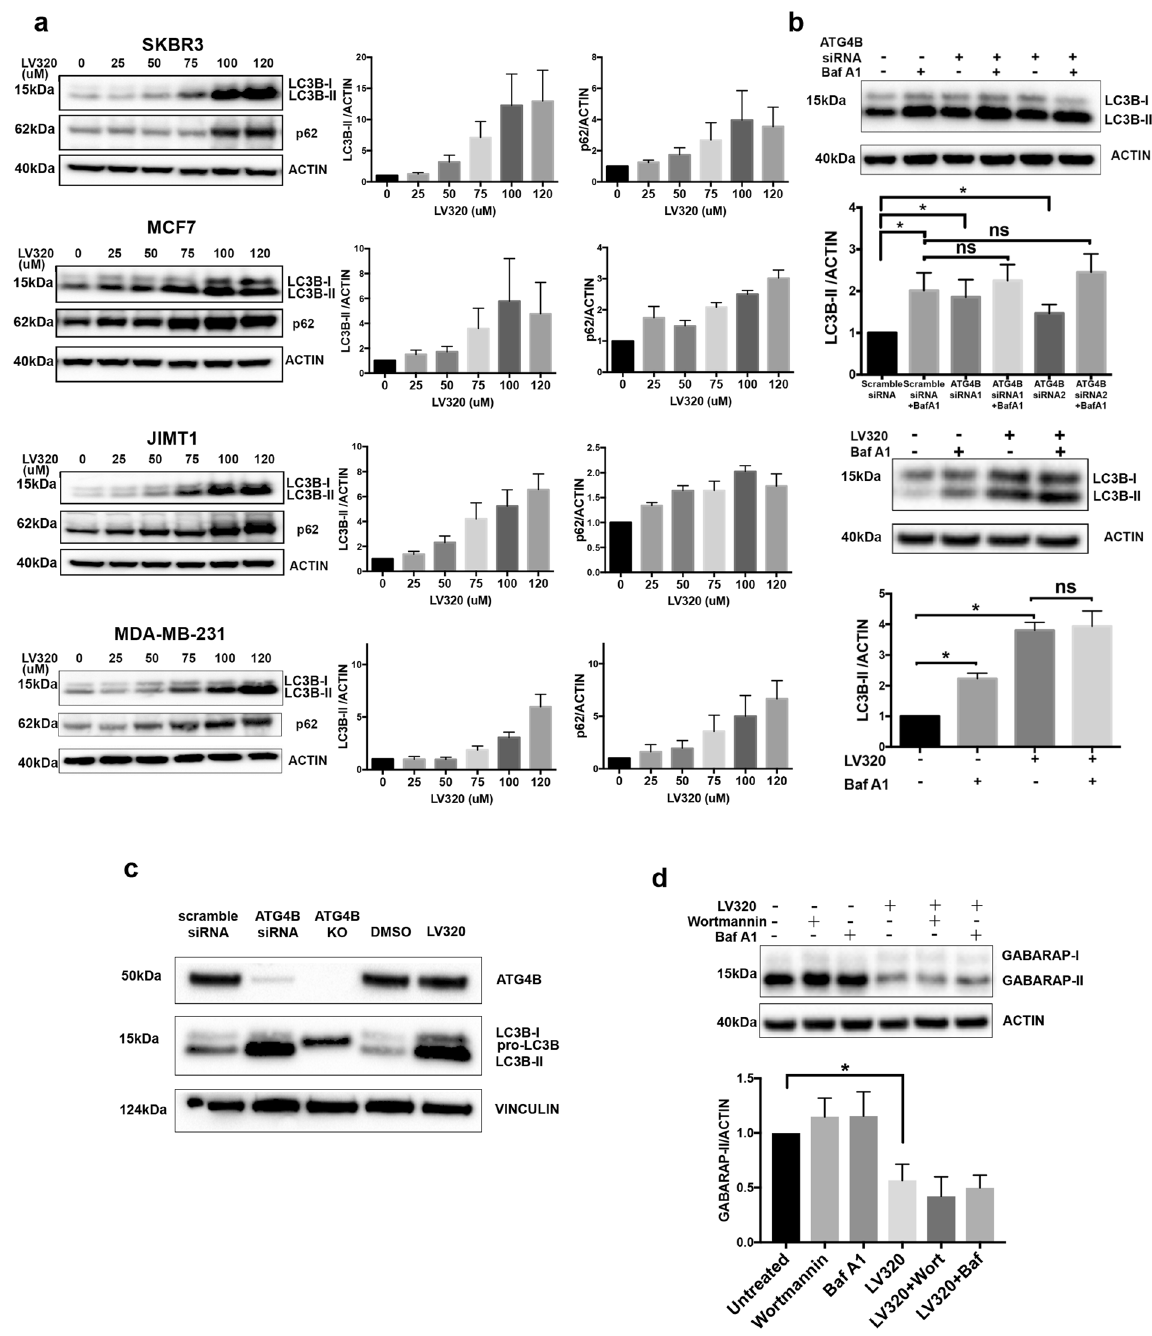
Figure 5. LV-320 blocks starvation-induced autophagic flux in vitro . ( a ) LV-320 treatment of SKBR3, MCF7, JIMT1, and MDA-MB-231 cells results in accumulation of LC3B-II and p62 in a dose dependent manner. Corresponding mean LC3B-II/actin values were determined using densitometry analysis; error bars, SEM (n = 3). Full-length blots are presented in Fig. S1. ( b ) LV-320 treatment, similar to ATG4B knockdown, results in inhibition of autophagic flux in MDA-MB-231 cells. Autophagic flux assay using saturating (40 nM) concentrations of bafilomycin A1 (Baf A1) was applied for the assessment of LC3B-II accumulation. Top: The representative western blot shows higher accumulation of LC3B-II following ATG4B siRNA treatment compared to scramble siRNA control; LC3B-II accumulation resulting from ATG4B knockdown is comparable to that from treatment with bafilomycin A1. Bottom: western blot shows higher accumulation of LC3B-II in cells treated with LV-320 (120 µ M for 48 hours) compared to DMSO control; addition of Baf A1 to LV-320 did not result in further accumulation of LC3B-II. Corresponding mean LC3B-II/actin values were determined using densitometry analysis; n = 3; error bars, SEM; * p < 0.05. Full-length blots are presented in Fig. S1. ( c ) LV-320 results in accumulation of LC3B-II and not pro-LC3B. Representative western blot shows parental JIMT-1 cells treated with scramble control siRNA (lane 1), ATG4B-siRNA (lane 2), vehicle control (lane 4), or LV-320 (75 µ M; 24 h; lane 5). The control ATG4B-KO JIMT-1 cells showing the location of pro-LC3B